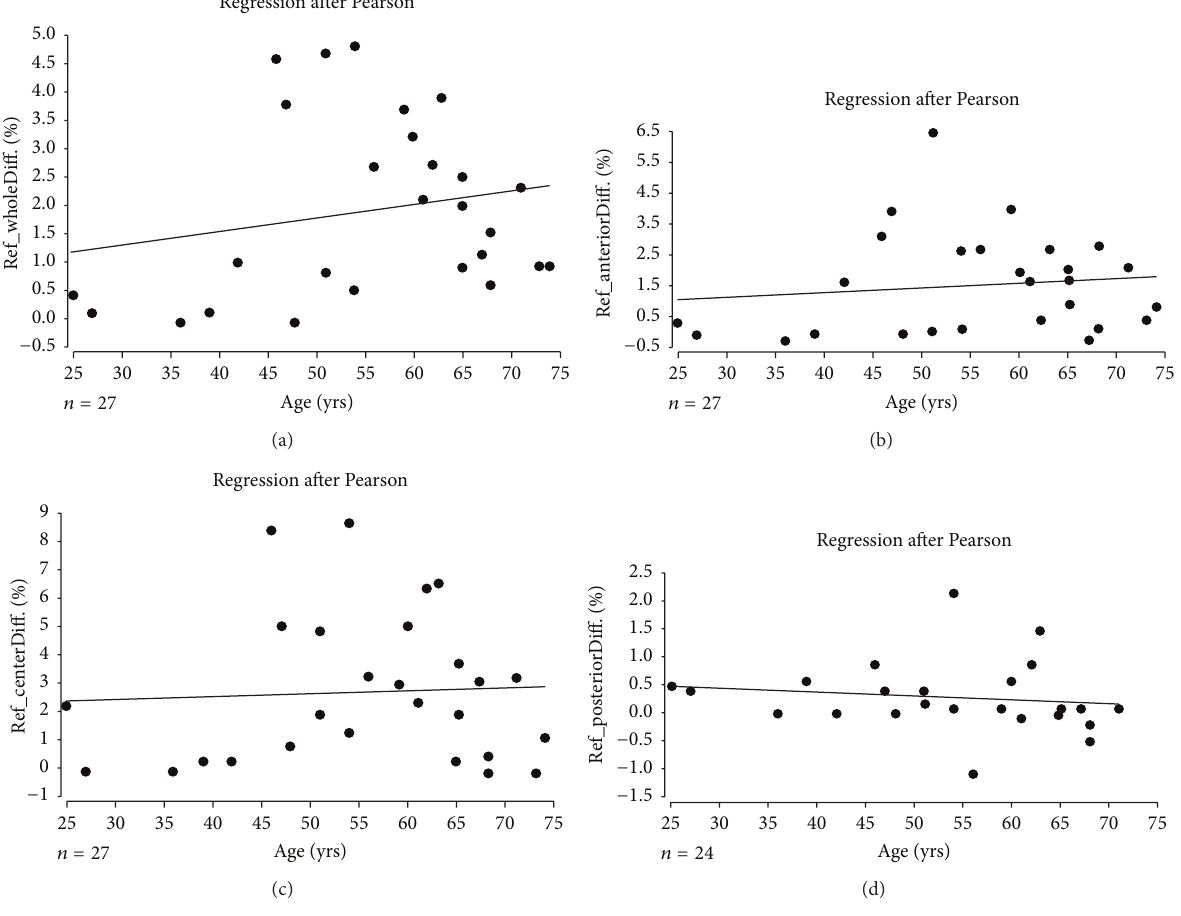
Figure 2: (a)–(d) Lens densitometry change in % for the reference body aligned through the whole lens (Ref wholeDiff.) (a), for the anterior reference body (Ref anteriorDiff.) (b), for the central reference body (Ref centerDiff.) (c), and for the posterior reference body (Ref posteriorDiff.) (d) with a diameter zone of 3mm, all plotted against the age. For the posterior reference body three patients could not be